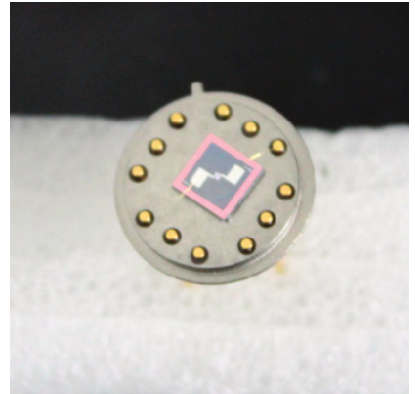
Figure 4. The mounted sensor